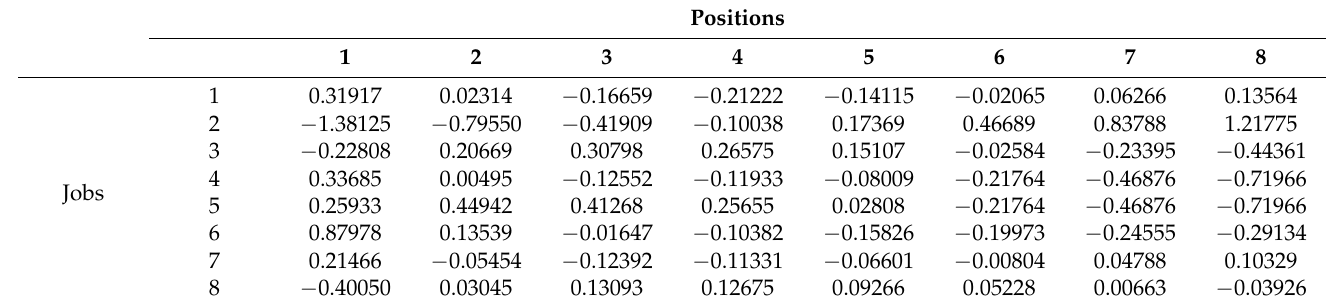
Table 5. Job-Job trajectory ( JJT ) matrix from 1000 random solutions for 8-job instance. Jobs